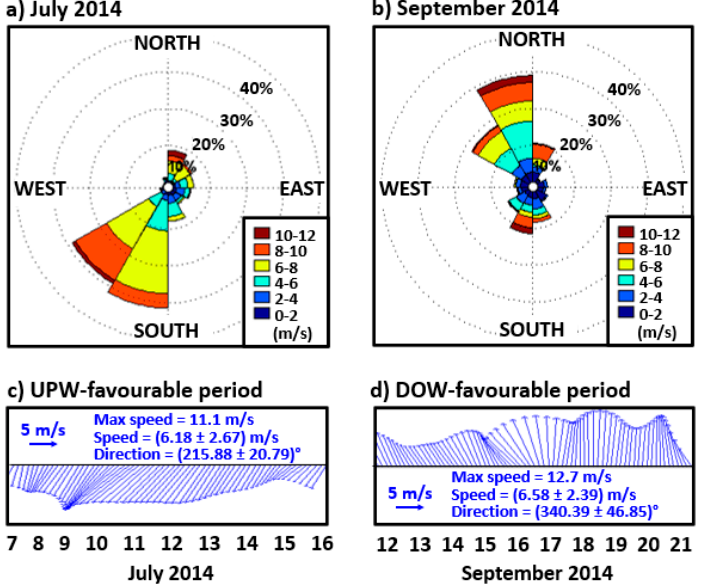
Figure 3. Wind roses, indicating predominant propagation direction at B1 buoy during July ( a ) and September ( b ) of 2014. Stick diagrams (depicted every 3 h) of hourly averaged wind during the 10-day upwelling-favorable ( c ) and downwelling-favorable events ( d ).